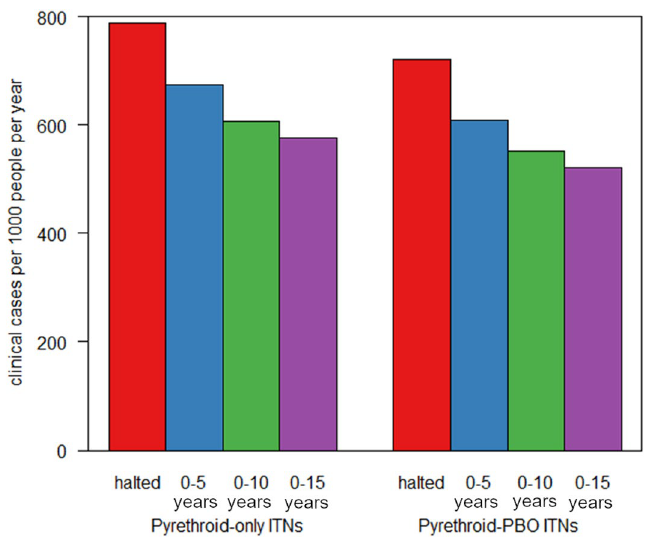
Figure 3. Clinical incidence of malaria predicted by either halting or extending the age range of the annual SMC campaign. Model predictions for the average number of clinical cases per year per 1000 people if SMC was halted (red bar), continued implementation across the existing target age (0–5 years, blue bar) or extended to 0–10 years old (green bar) or 0–15 years (purple bar). Incidence is averaged over the whole population (all ages) over a three-year period following the change in policy to reflect the regularity of mass ITN campaigns. ITNs are assumed to be either pyrethroid-only ITNs (left bars) or pyrethroid- piperonyl butoxide (PBO) ITNs (right